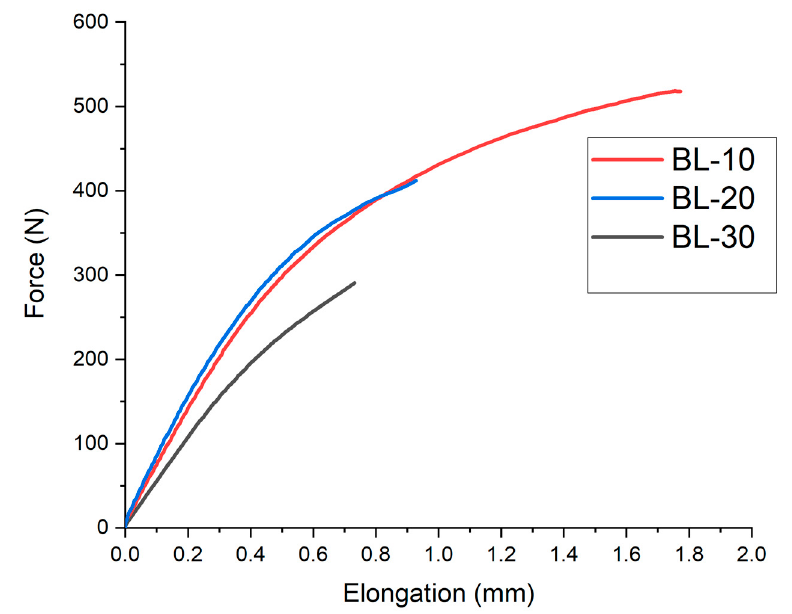
Figure 6. Force ‐ elongation trends of composites of PHB reinforced with BL barley fibres tested after 14 days of exposure to environmental conditions.